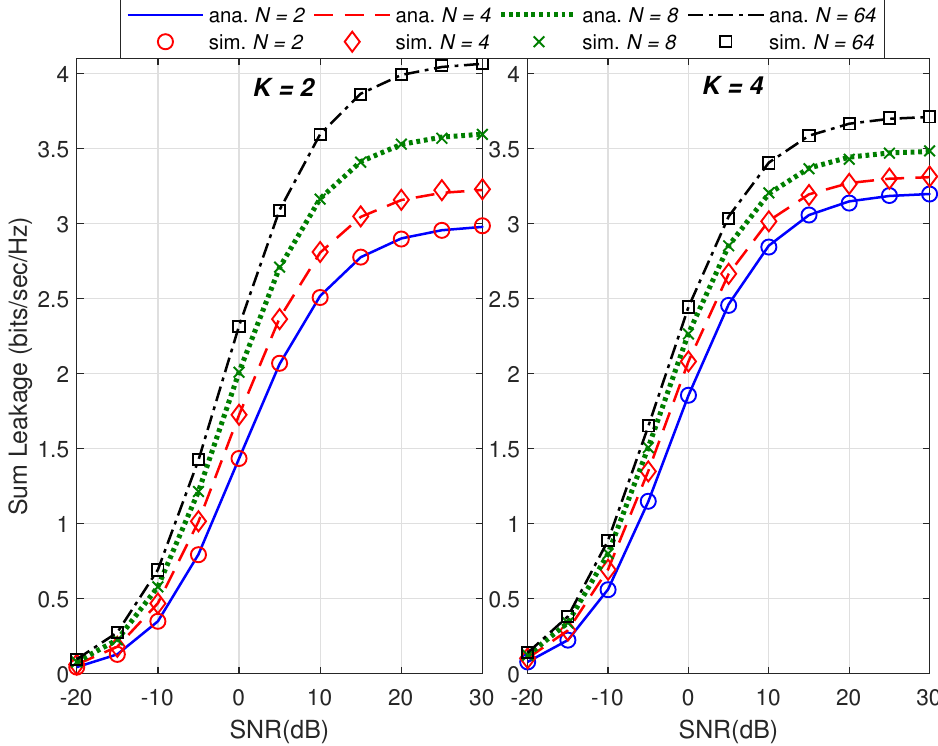
Figure 2. Comparison of analytical and simulation results of the sum leakage rate versus the transmit SNR in